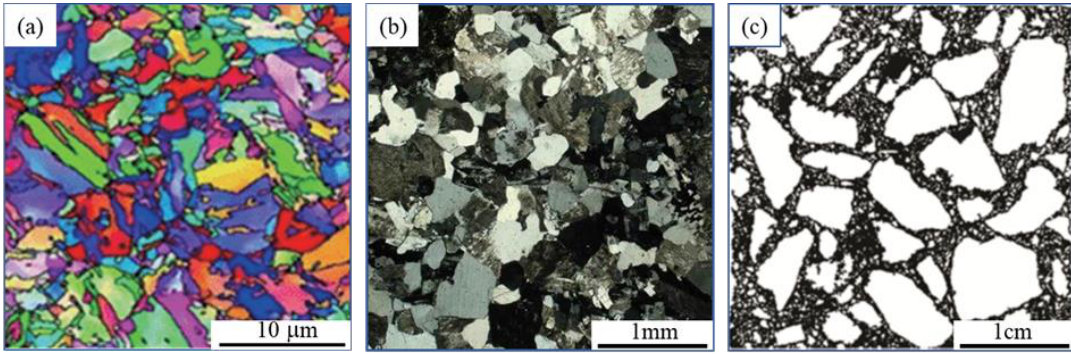
Figure 1. Scanning images of solid materials at different scales: ( a ) twin structure of carbon steel; ( b ) fine grain structure of granite; ( c ) meso structure of concrete.